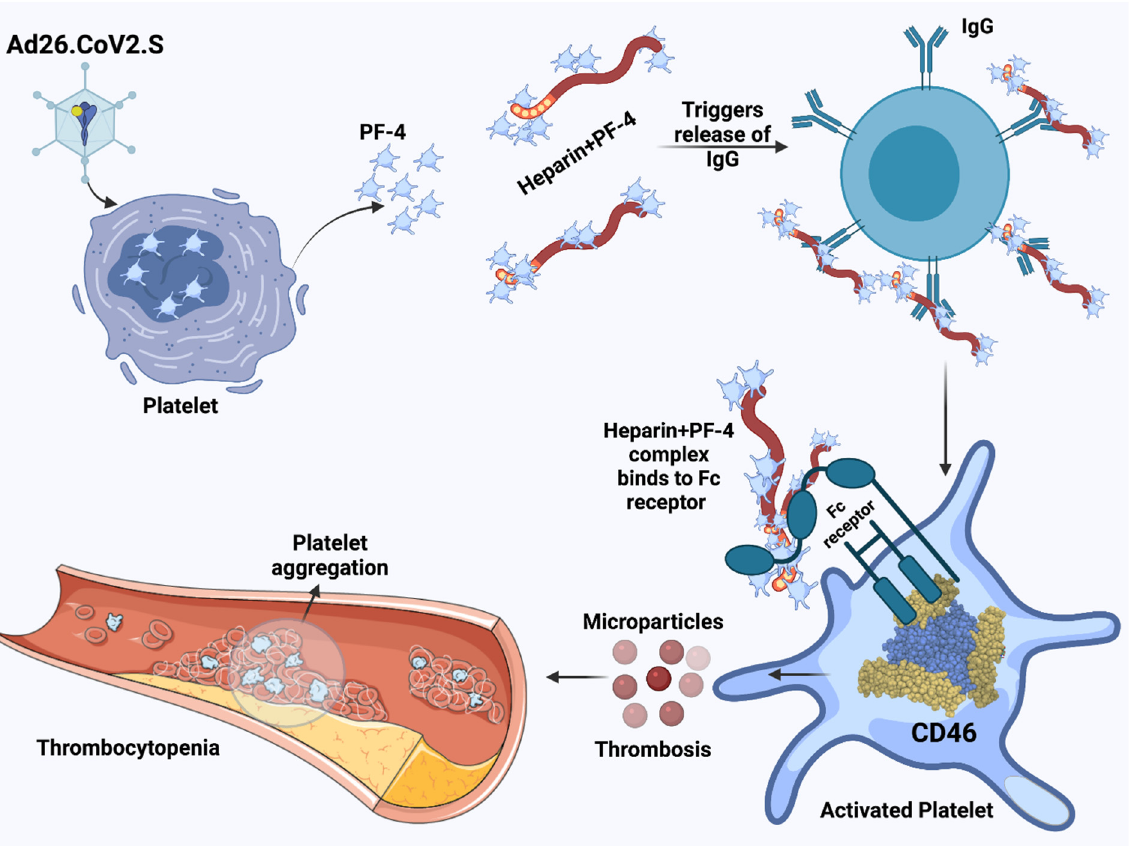
Figure 3. Heparin-induced Thrombocytopenia. Proposed mechanism of thrombocytopenia induced after Ad-based vaccine administration. Figure was created with Biorender.